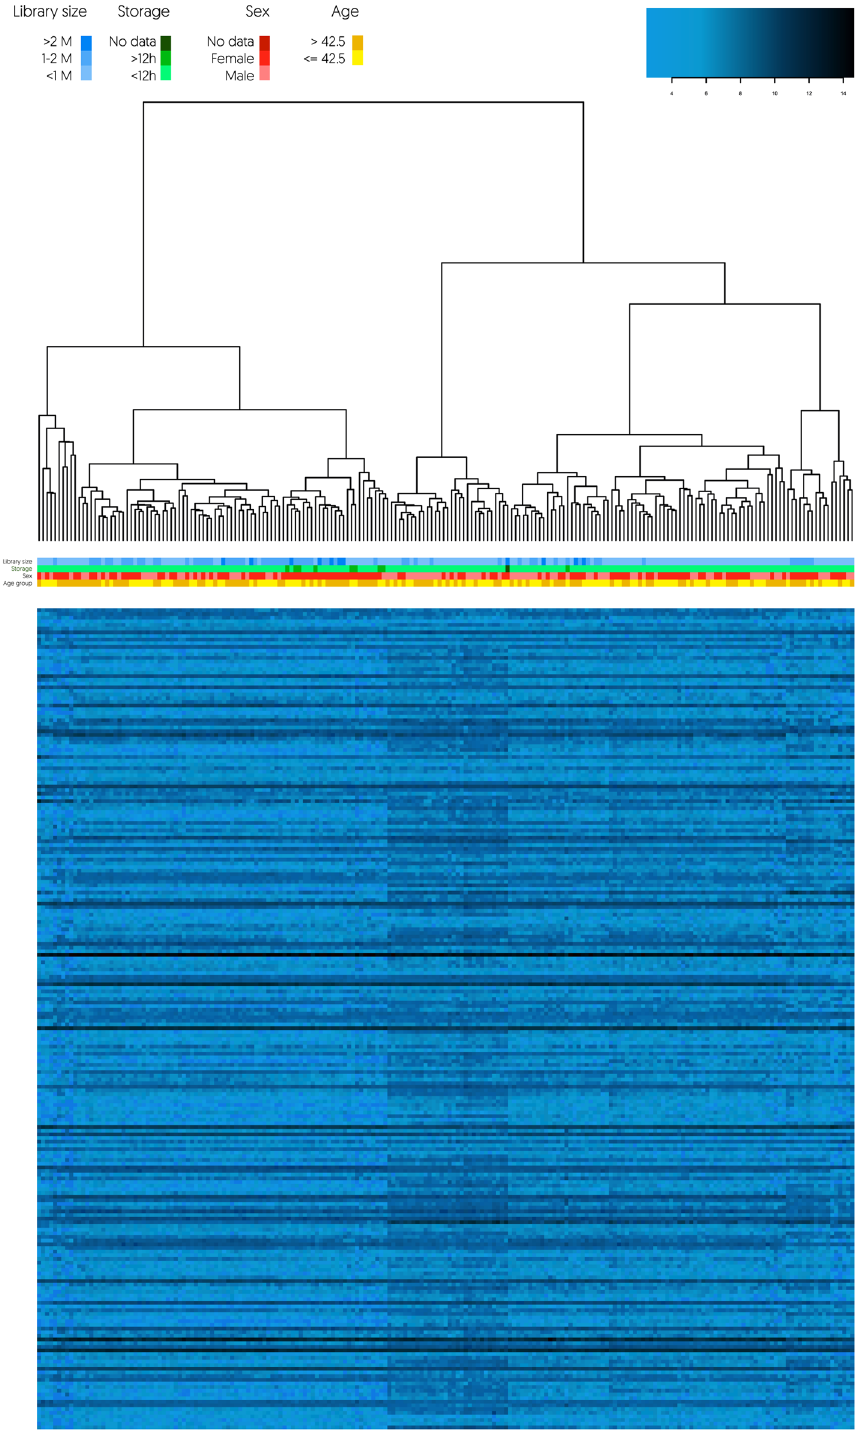
Figure 5. Heatmap depicts the expression of 224 spliced genes with the greatest, at least fourfold mean changes between the two clusters revealed by unsupervised hierarchical clustering. Colour legend indicates the sex, age group, blood collection unit, storage time and library size of each sample. The clusters presented substantial similarity in terms of the expression of spliced junction reads. 62% of spliced platelet RNAs demonstrated less than a twofold expression difference. Only 16% of spliced genes in the dataset (649/3954) demonstrated at least a threefold expression difference, while at least fourfold difference was observed in only 6% of the spliced reads (224/3954). Due to prior clustering, all these observations were statistically significant (FDR corrected q value <